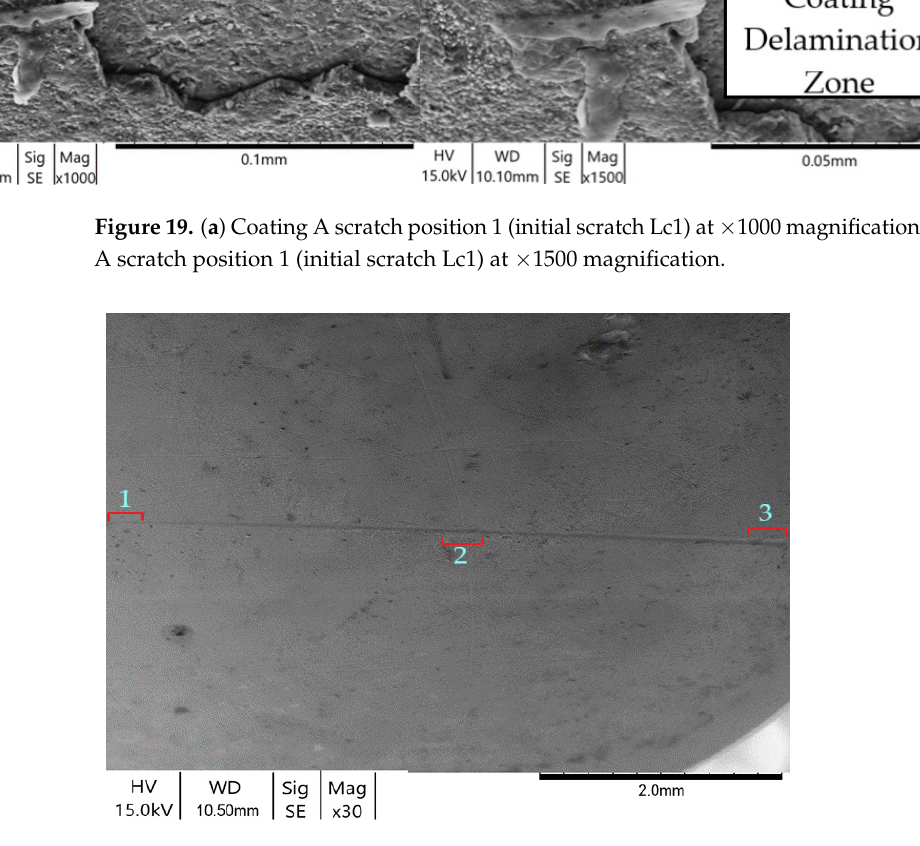
Figure 20. Coating B scratch positions 1, 2 and 3 at × 30 magnification.